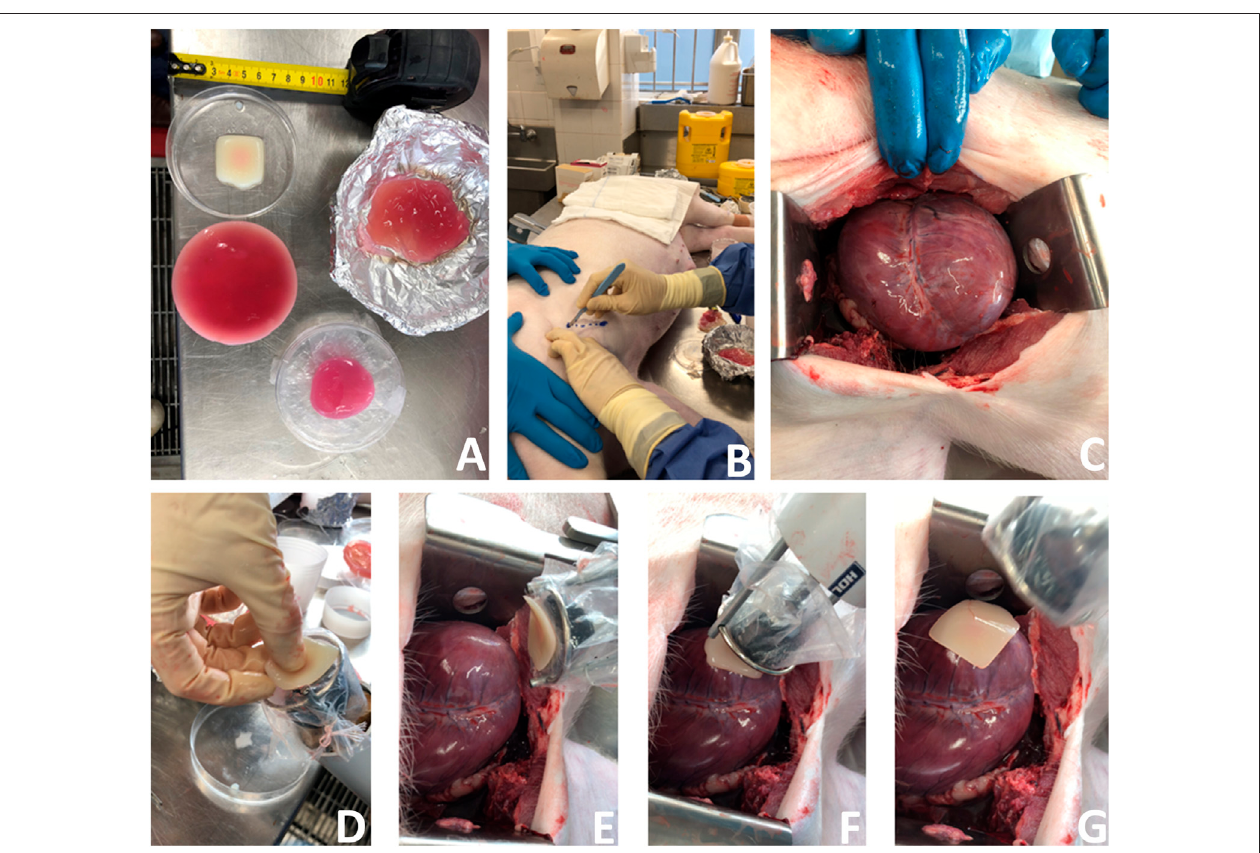
FIGURE 8 | A new surgical operation for epicardial patch transplantation using the HeartStamp — left anterolateral approach with sheath. This surgery was performed once in real time, accepting complications to more closely simulate real surgical conditions (because the heart was enlarged and not accessible using the usualanatomicallandmarkwehadtoconvertthisoperationtoanopen(notkeyhole)approach — acomplicationwhichhappensinhumancardiothoracicsurgeryaswell). We chose to continue and report the operation exactly as it happened. (A) Patches for cardiac applications were created using alginate/gelatin hydrogel by 3D bioprinting(thewhitepatch)ormouldingtechniques(pinkpatches). (B) Aleftanterolateralsurgicalincisionwasmadeinafreshcadaverofapigwhichhadrecentlydiedof unrelatedcauses. (C) Theincisionwasextended,thechestwalltissuesretracted,pericardiumcuttoexposetheheartandtheheartmanouvredslightlyintoposition. (D) The3Dbioprintedpatchwasmanuallyappliedtotheplasticsheathatthedistal(patient)endoftheHeartStampinstrument. (E) TheHeartStampwasmovedintoposition by the surgeon and the patch remained lightly adherent to the plastic sheath. (F) The patch was transplanted to the epicardial surface over the left ventricle. (G) The HeartStamp is withdrawn, leaving the patch in situ on the epicardium. To complete the operation, the patch was then secured under the pericardium and the chest closed surgically.